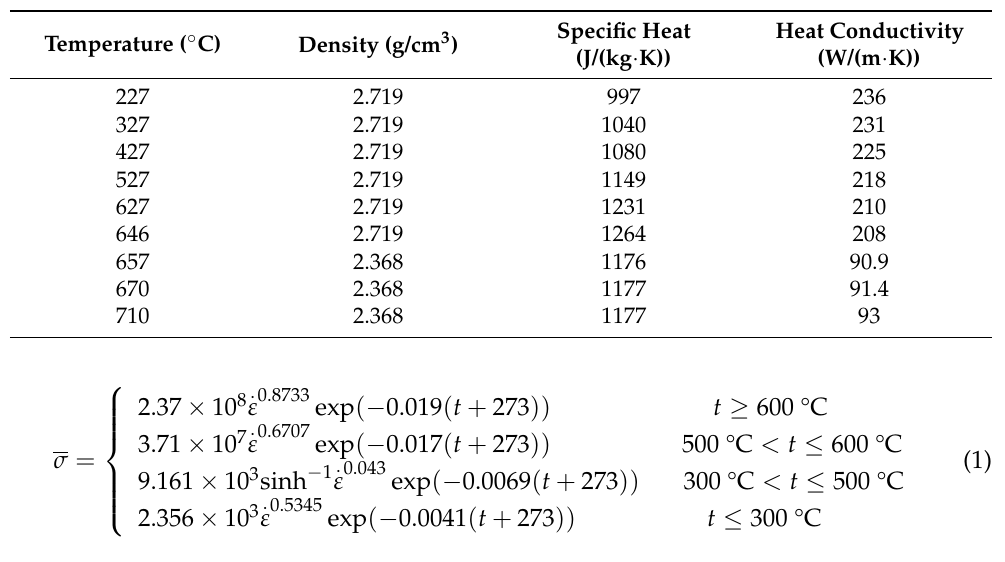
Table 2. Thermophysical properties of 1060 aluminum alloy.